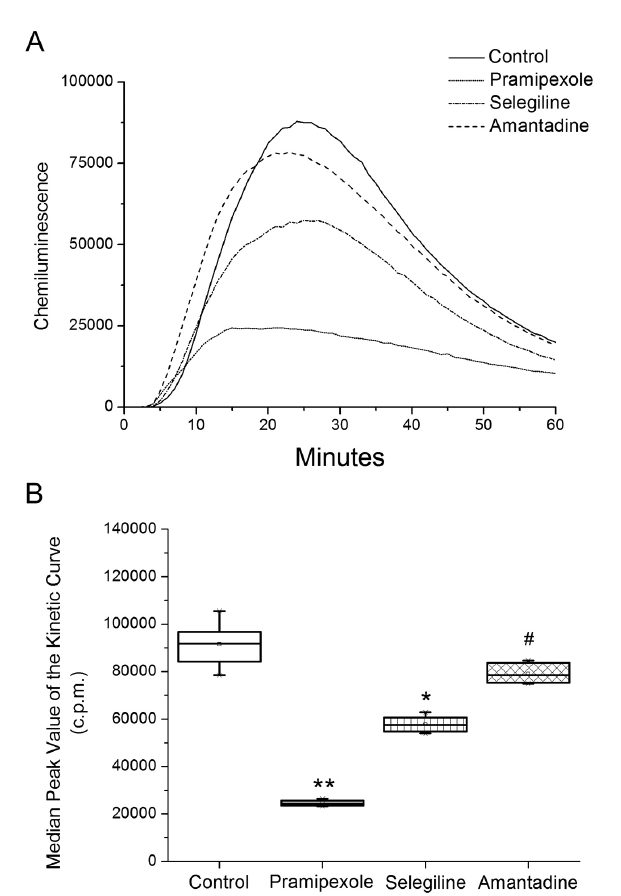
FIGURE 1 – Effect of antiparkinsonian drugs (10 -4 M) on the activation of human neutrophils by PMA. Each group was composed by at least 14 replicates. A. Kinetic curves obtained each minute for 60 minutes. B. Box plot of the peak values on the kinetic curves. Data were analyzed by Kruskal-Wallis complemented with Dunn´s test. *p< 0.01 compared to control;